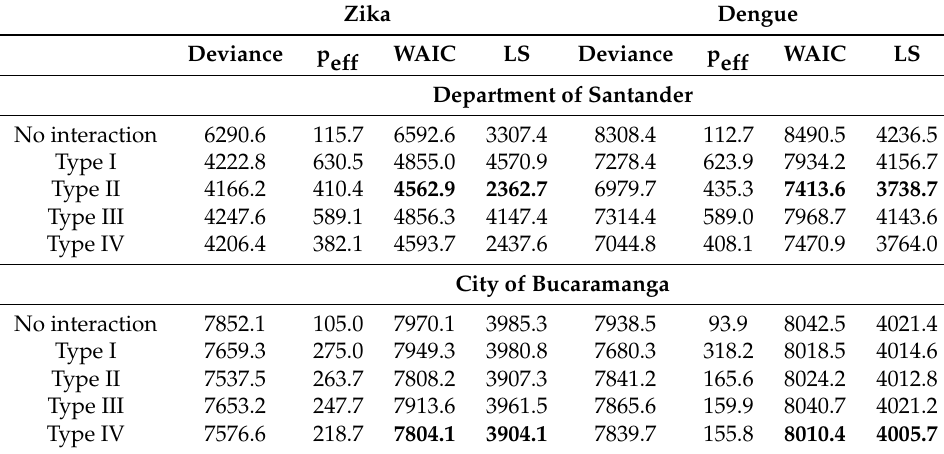
Table 1. Selection statistics (deviance, effective number of parameters (p eff), Watanabe